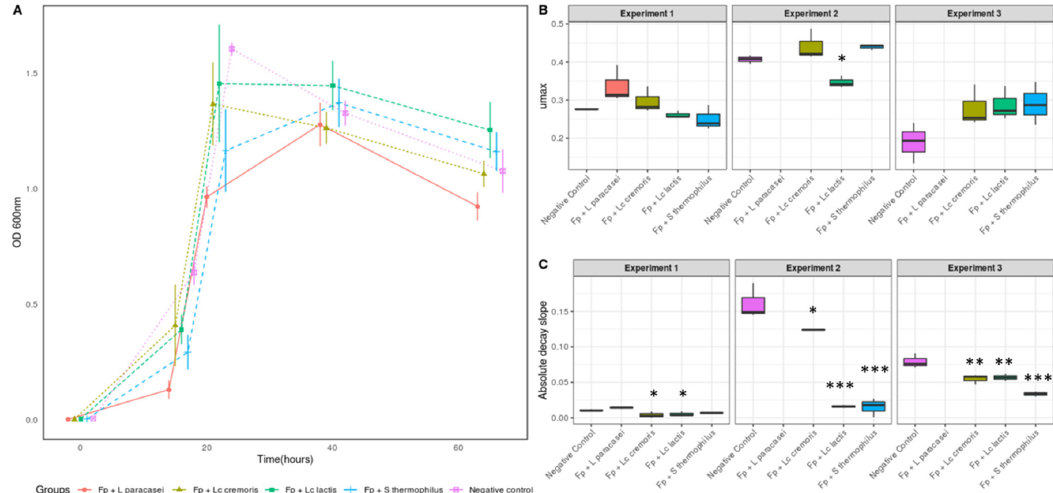
Figure 1. F. prausnitzii growth exposed to cell-free supernatants of lactic acid bacteria ( A ) F. prausnitzii A2-165 growth, as assessed on the basis of the OD 600 values for the supernatants with the